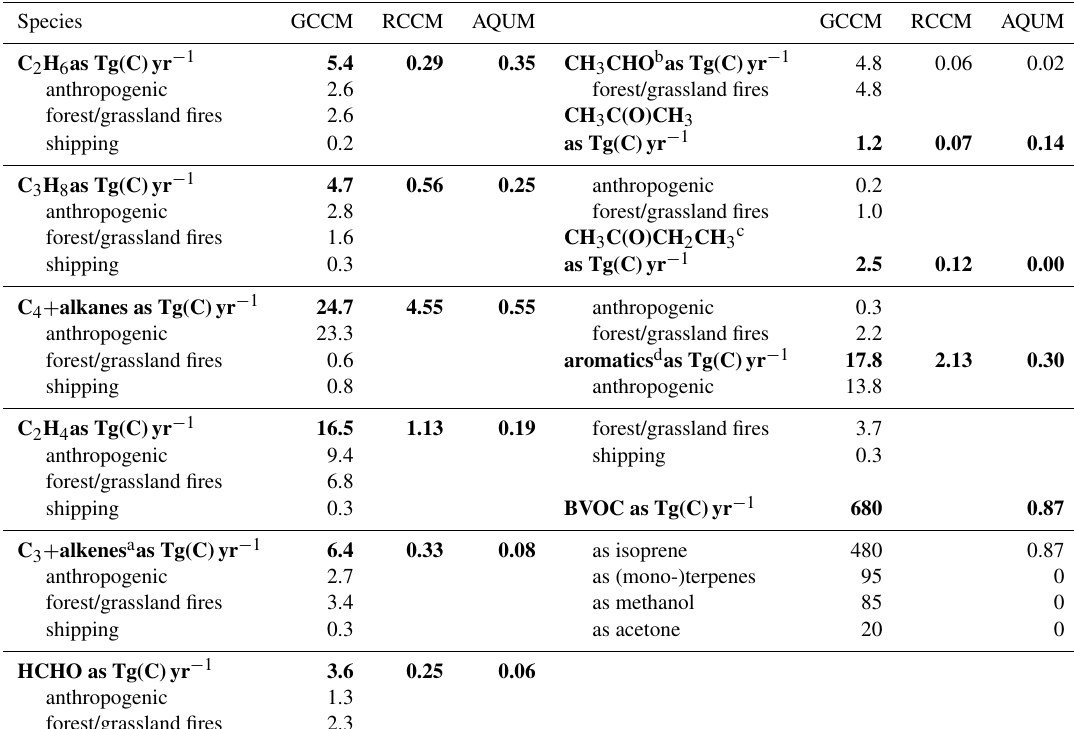
Table A3. Summary of the annual total emissions of volatile organic compounds used in the GCCM, RCCM, and AQUM models. Bold type shows the annual total for each species.